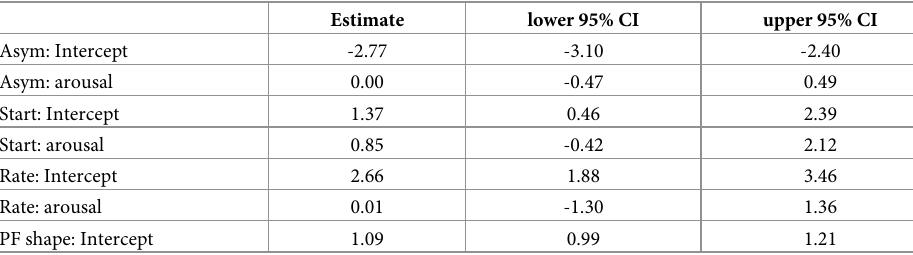
Table 6. Coefficient and CI from model testing arousal-manipulation effects in